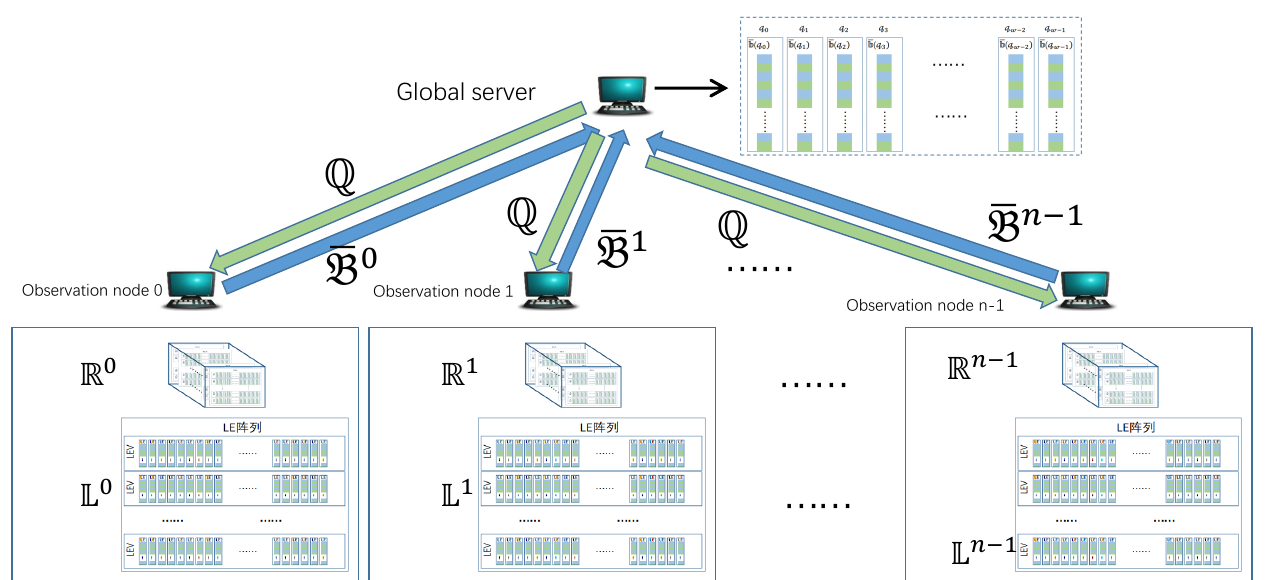
Figure 8. Collect candidate LE in a distributed